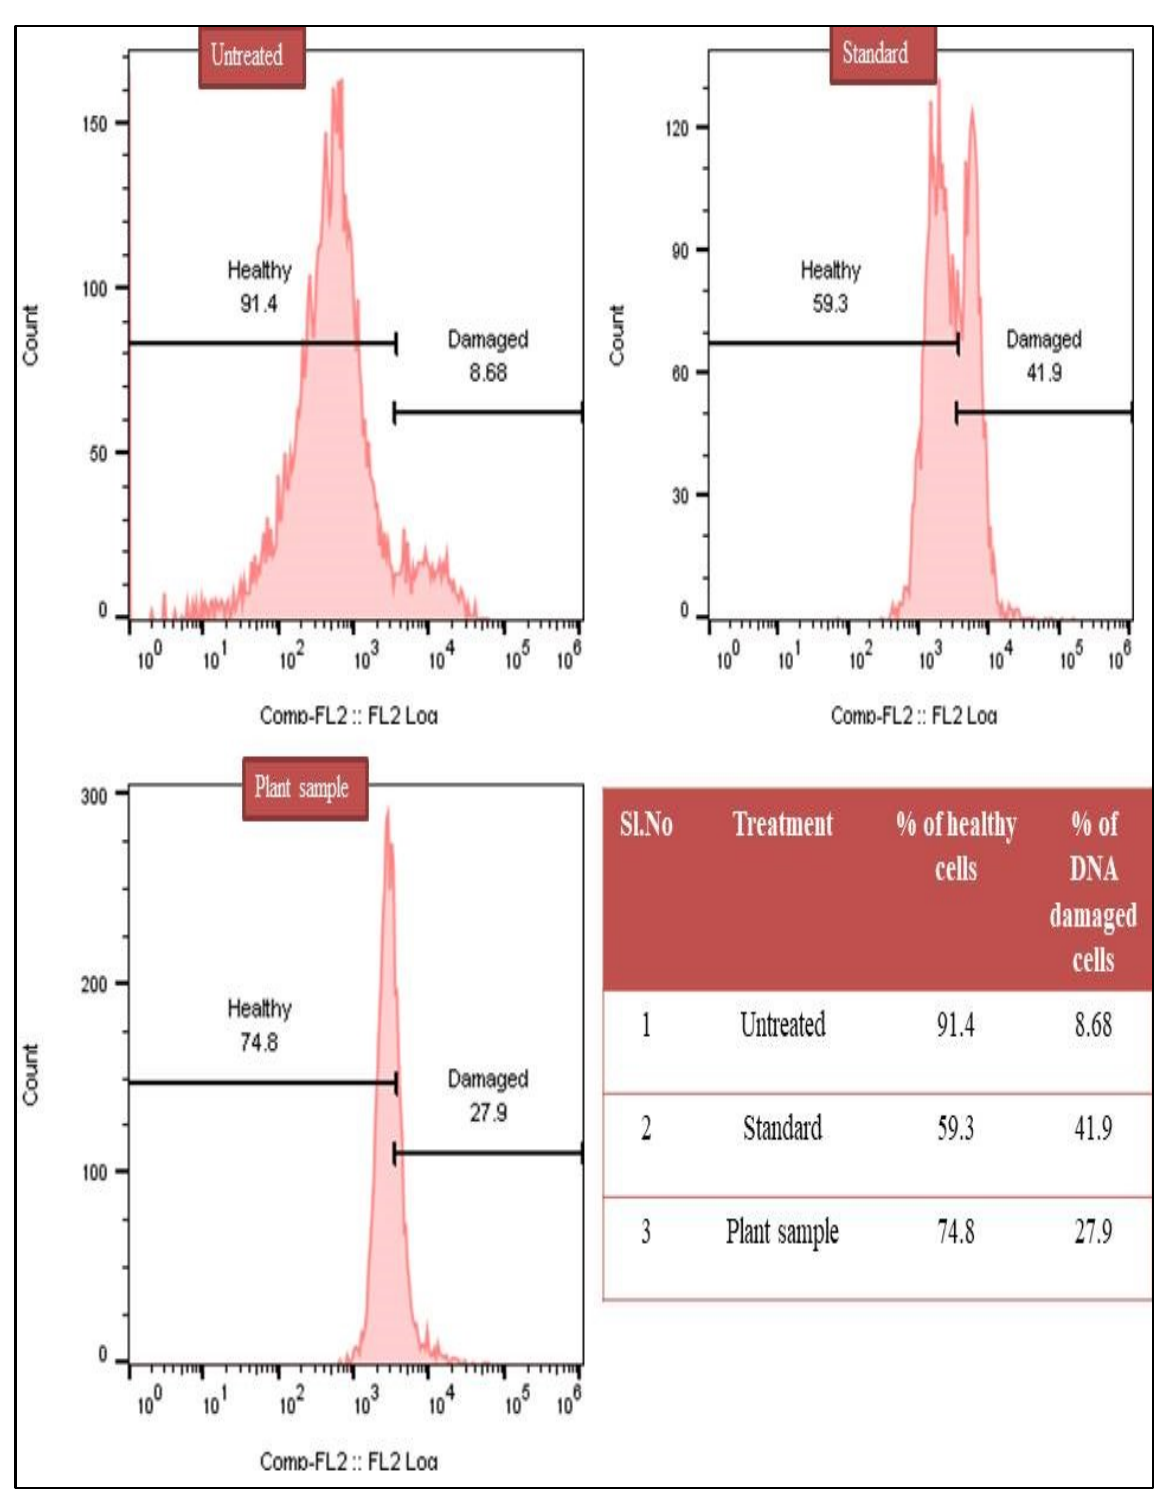
Figure 4. Flow cytometry-based study of DNA damage induced by methanol extract of the Tribulus plant in the breast cancer MCF-7 cell line.